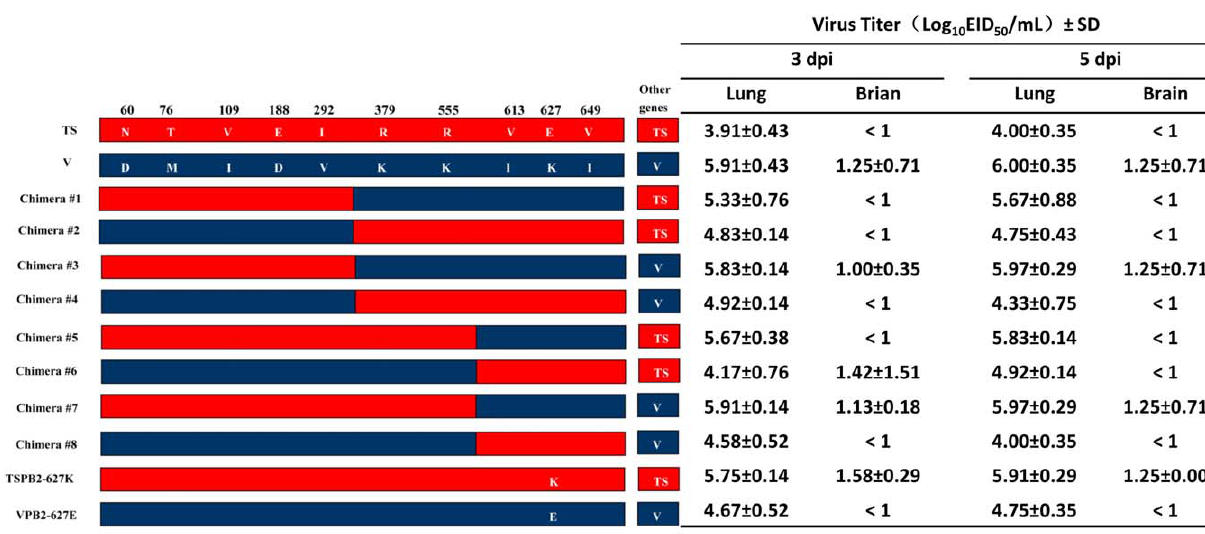
Figure 3. Schematic diagram of chimeric and single amino acid PB2 mutants and virus titers in mouse lungs and brains. Differences of amino acid residues in PB2 between TS and V virus were shown as single-letter amino acid codes with their positions indicated at the top of the diagram. The red and blue bars indicate the amino acid regions originated from TS or V, respectively. Virus titers are presented by log 10 geometric mean EID 50 /ml 6 SEM (The detection limit is 10 1 EID 50 /ml).